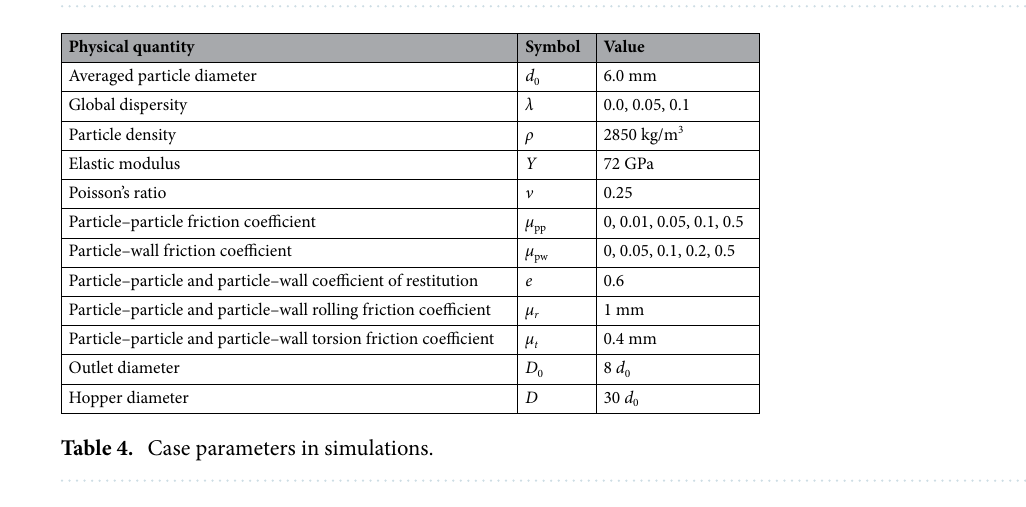
Figure 6. Vertical stress σ zz along z axis in ( a ) Case A* ( λ = 0) and ( b ) in Case C* ( λ = 0.1) (see Table 3). ( c ) σ zz in the radial direction at z / d 0 = 100. The vertical line marks the radius of outlet. ( d ) Temporal profile of instantaneous mass flow rate in Cases A*, B* and C*.